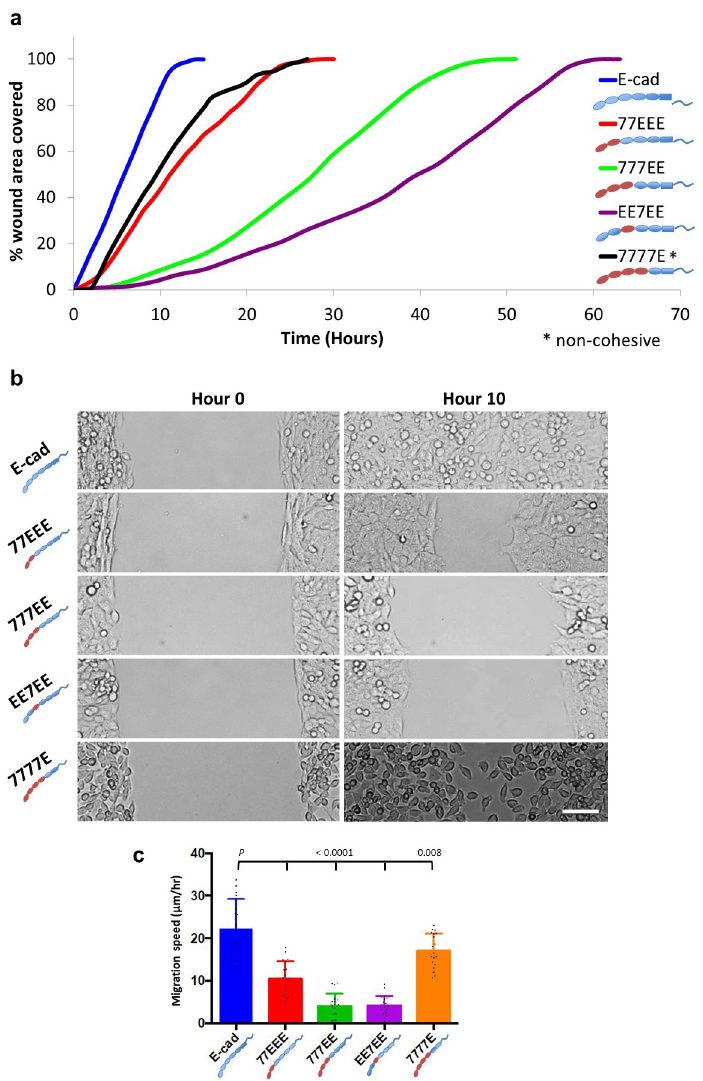
Fig 6. Wound healing assay. (a) Representative curves showing the time taken to cover a 500- μ m unwounded gap. All groups migrated collectively, except 7777E-expressing cells. E-cad expressing cells migrated fastest, followed by 77EEE- expressing cells. 777EE- and EE7EE-expressing cells took approximately 4- to 5-times longer than the time taken by E- cad-expressing cells. The migration speed of 7777E-expressing cells is comparable to that of E-cad-expressing cells; however, these cells migrated as a non-cohesive cell assembly, as the cell-cell adhesion in these cells is transient. (b) Representative images from each group showing the position of cells at the beginning and end of 10 h of migration. Scale bar, 50 μ m. (c) Histogram showing the cell migration speed of all the groups. (E-cad, n = 17; 77EEE, n = 19; 777EE, n = 20; EE7EE, n = 20; 7777E, n =